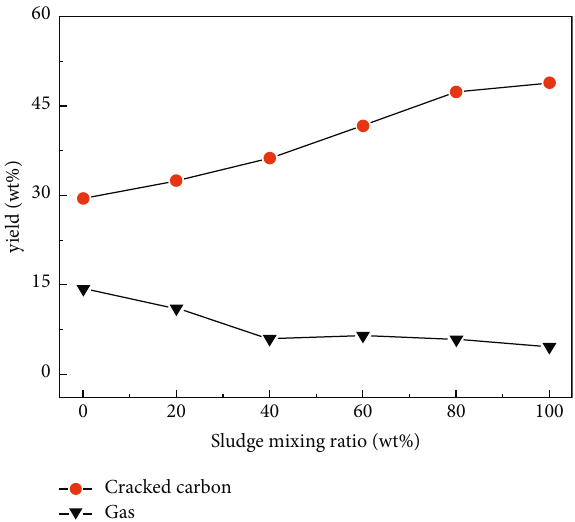
Figure 10: Copyrolysis gas and solid two-phase products of peanut shells and sludge vary with the mixing